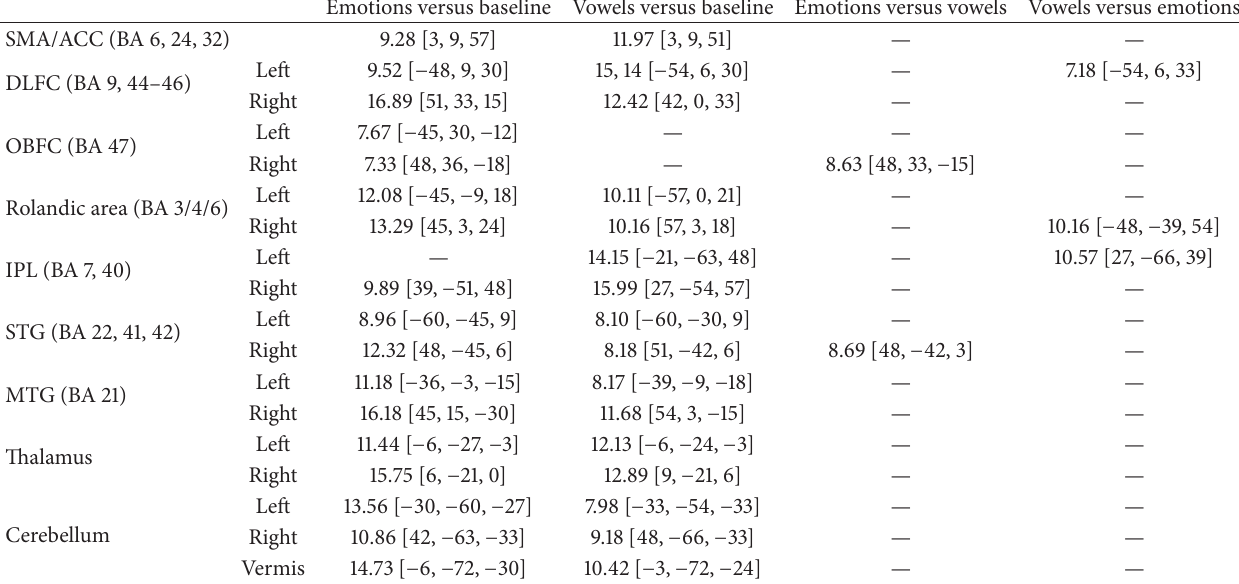
Table 1: Hemodynamics activation during identification of emotions and